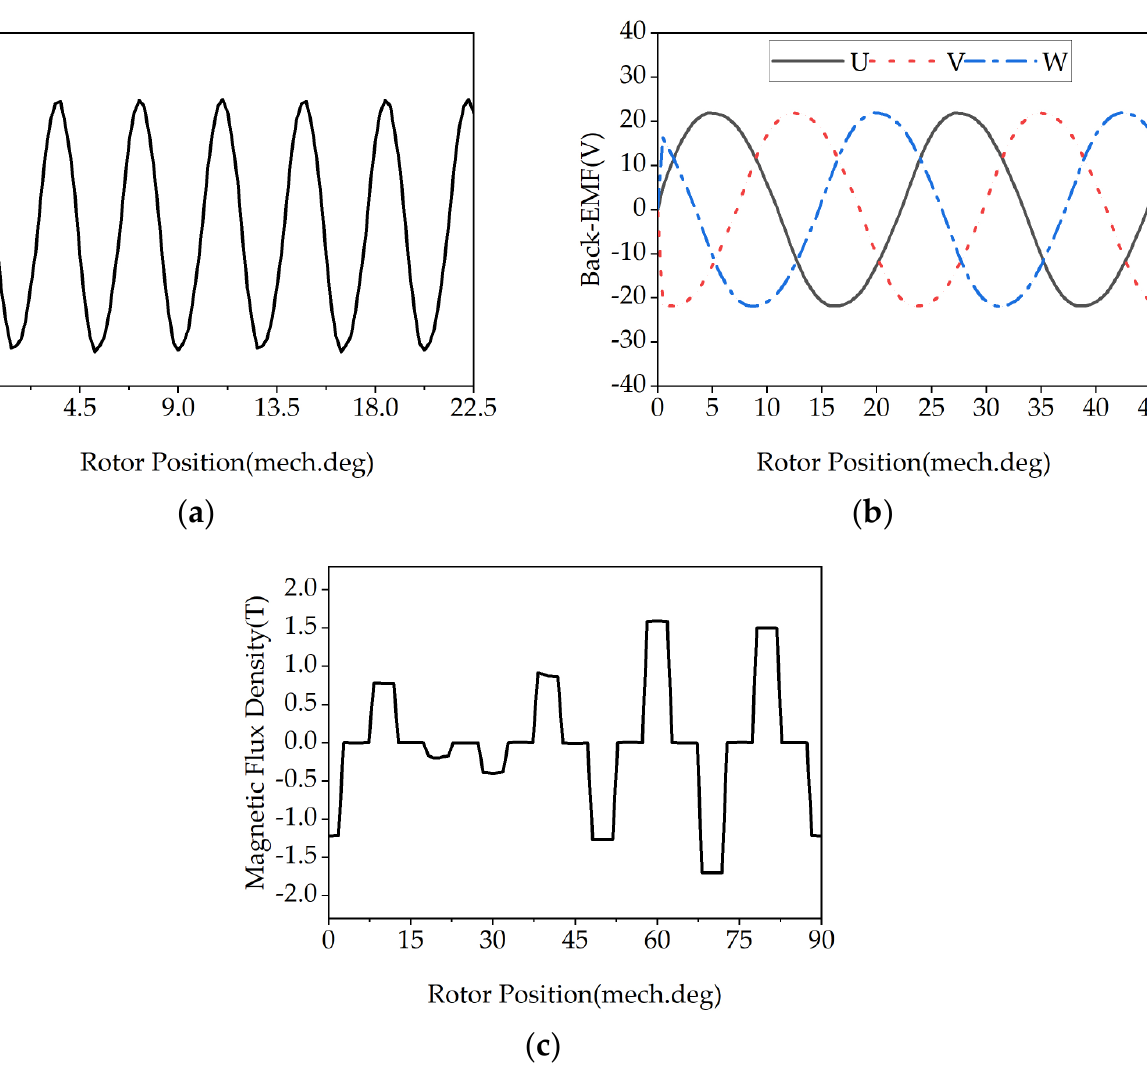
Figure 7. The simulation results under the rated load. ( a ) Output torque; ( b ) phase back-EMF; ( c ) tooth magnetic density.